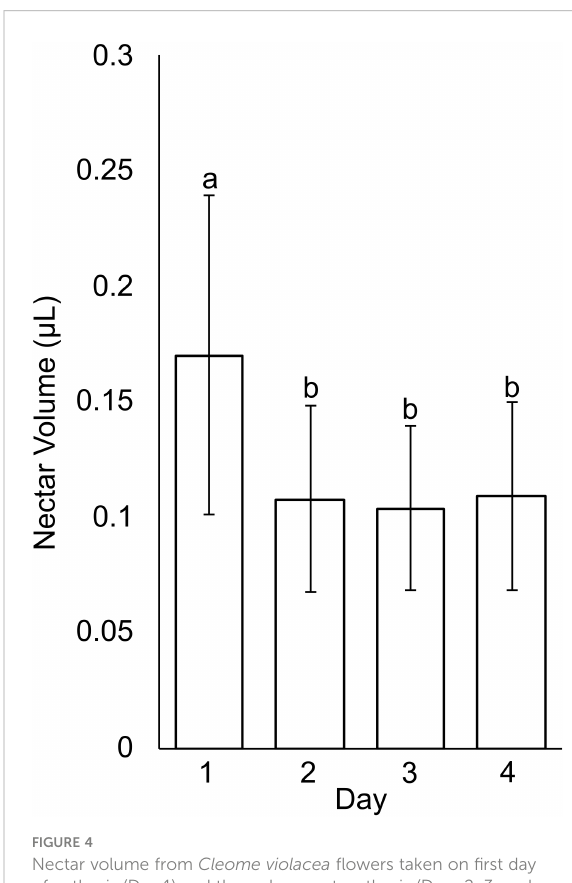
BA FIGURE 5 Z-score heatmaps of (A) all differentially expressed transcripts and (B) transcripts with TPM > 100 from Cleome violacea pre- anthetic, anthetic, and post-anthetic nectaries.